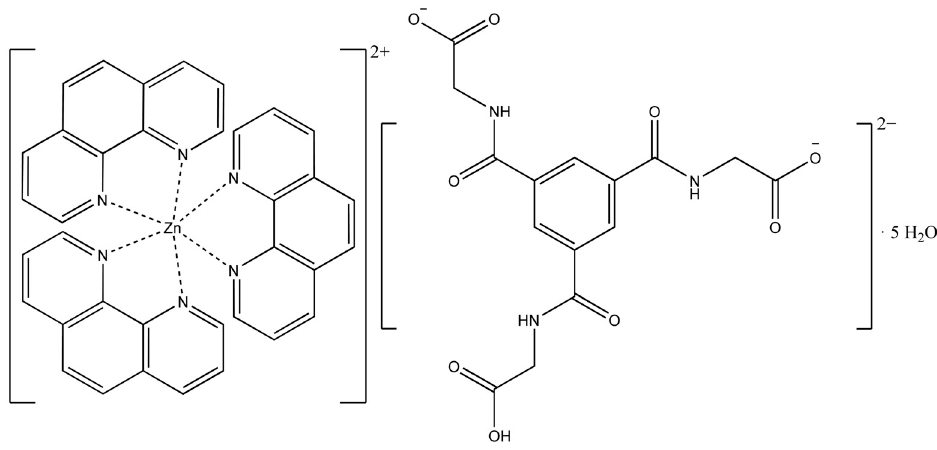
Scheme 1. Schematic representation of the structure of tris(1,10-phenanthroline)zinc(II)-cation and N,N ′ ,N ″ -tris(carboxymethyl)-1,3,5-benzenetricarboxamide dianion, and water molecules